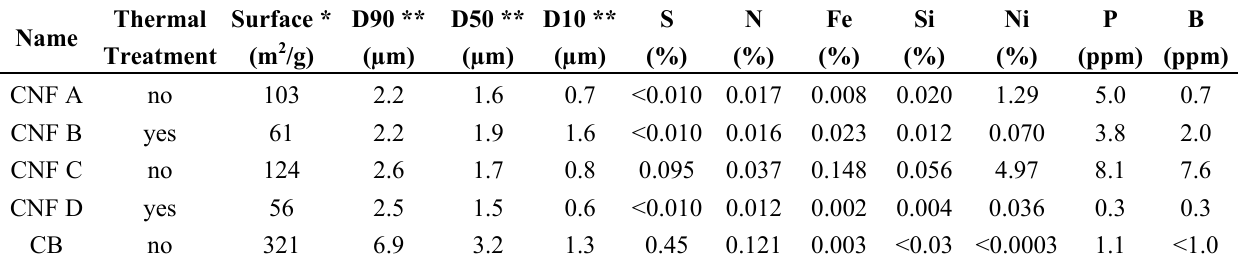
Table 1. Characteristics of carbon nanofibers (CNFs) and carbon black